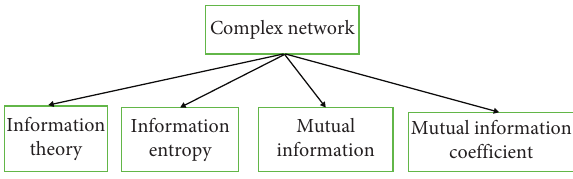
Figure 1: Complex system framework.